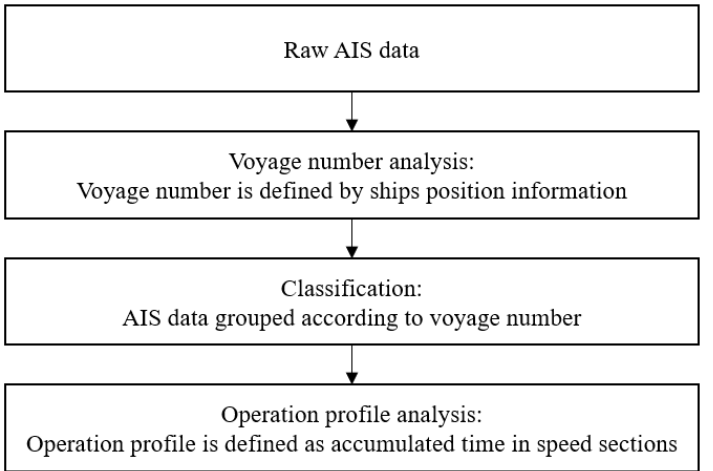
Figure 1. Flowchart of data preprocessing.